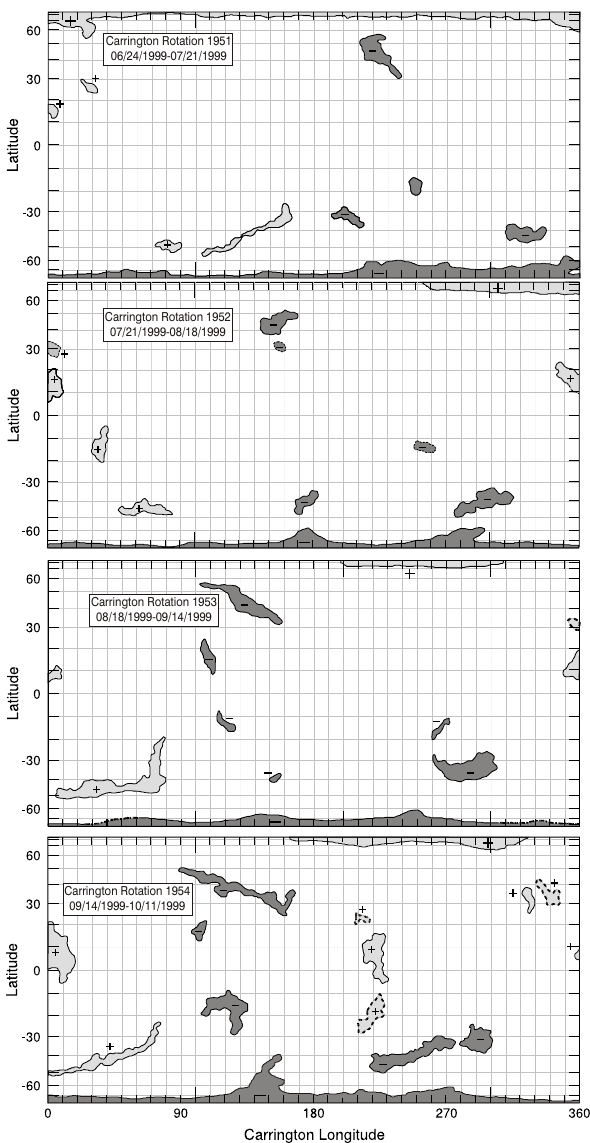
Fig. 5. He I λ 1083 nm coronal hole maps from Kitt Peak. Light grey is outward polarity and dark grey is inward